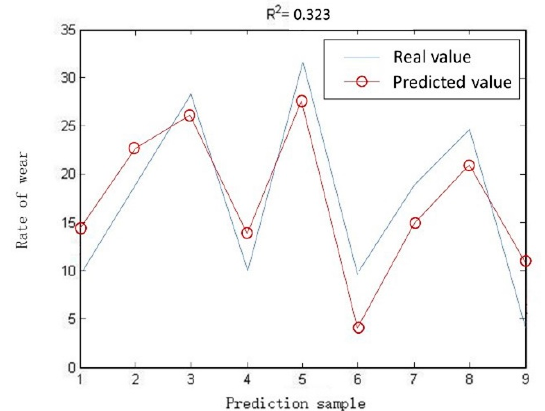
Figure 20. Comparison of the true value of the test sample and the predicted value based on other method.